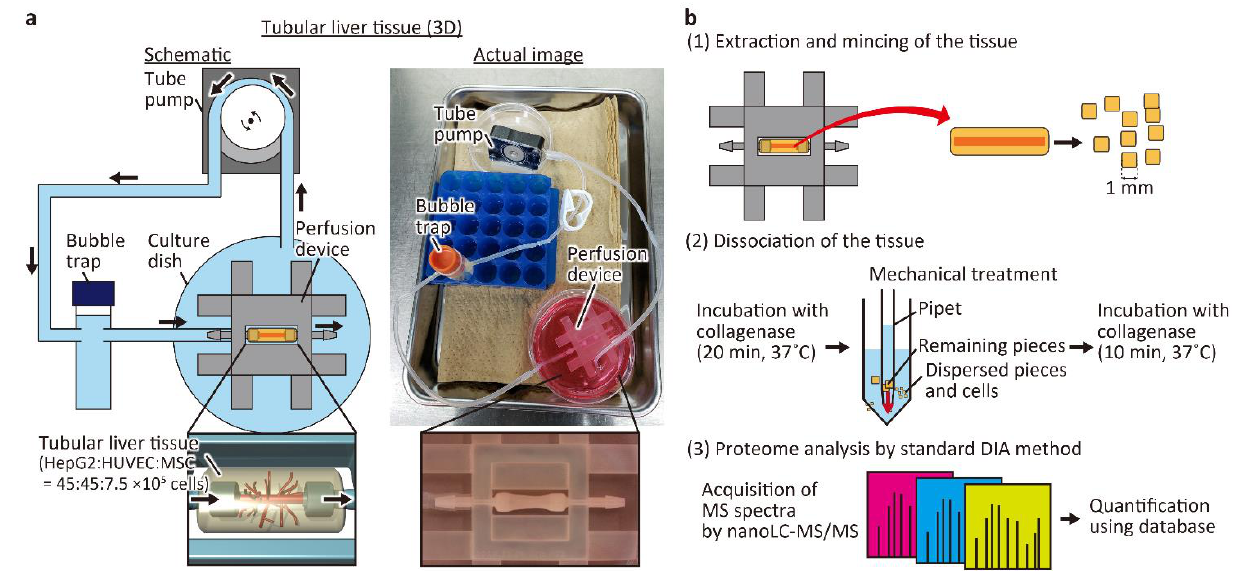
Figure 1. Conceptual diagram and procedure of the experiment. ( a ) Schematic and actual images of the perfusion system for the tubular liver tissue. The medium in the culture dish is aspirated by the tube pump, passed through the bubble trap, and delivered to the tubular liver tissue in the perfusion device. The medium that has passed through the tubular liver tissue is released into the culture dish and circulated again by the tube pump. ( b ) Proteomic analysis procedure of the tubular liver tissue.